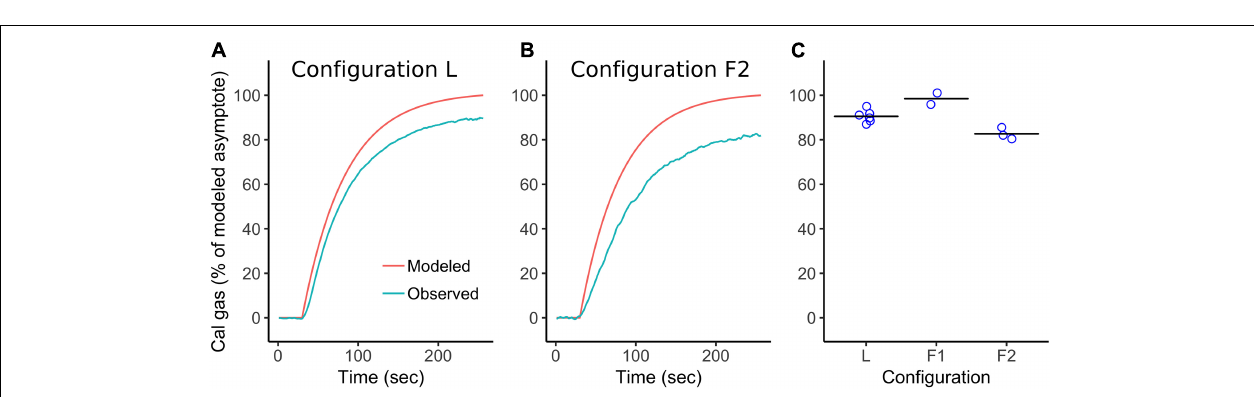
FIGURE 8 | One of three uniquely shaped leaf cuvettes, designed to accommodate a range of leaf shapes and sizes. The leaf is inserted into the opening at right, and the petiole settled into the U-shaped slot. Tensioned cords seal the faceplate with the PTFE gasket to the front of the box, with its inverted U-shaped slot and petiole gasket opposing those on the cuvette face. The petiole gasket is loosely sealed around the petiole with cord such that excess flow (150 mLpm or greater) can escape, but diffusive gas exchange with outside air is not permitted. Light panels mount to the top of the cuvette to drive photosynthesis. Reflective siding ensures even light distribution and minimal interference from ambient light.